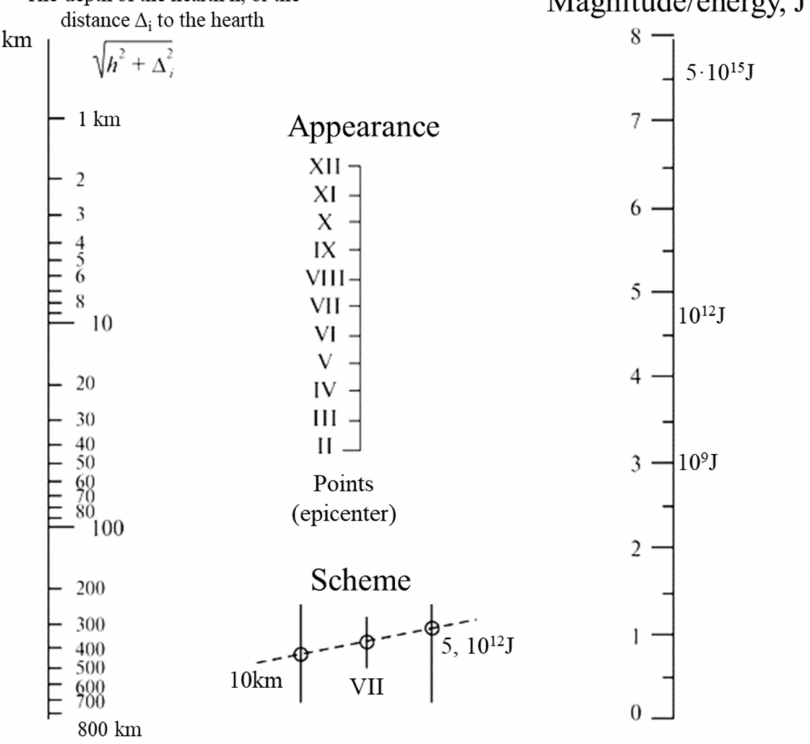
Figure 8. Highest probability for catastrophic water events (by analysis from different sources): magnitudes, intensity (in points/earth scores), and focal depth (hypocenters) that cause catastrophic floods when an earthquake occurs. The data shown as a scheme is the max-risk for the event (all the above 3 factors come